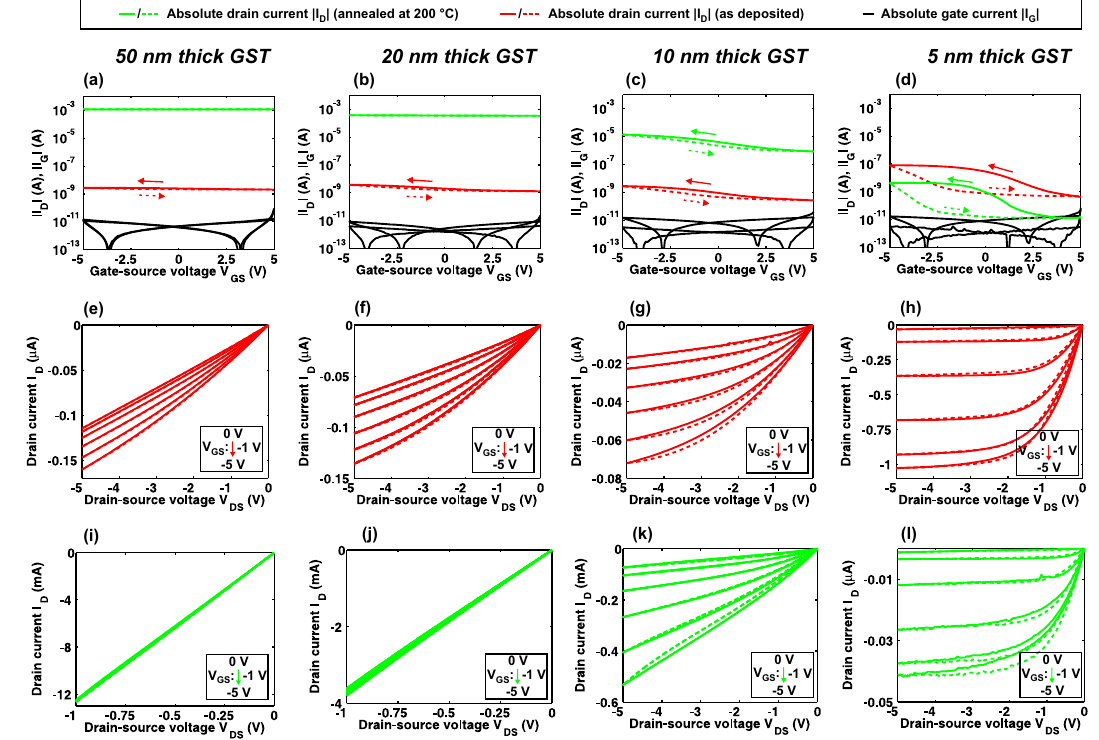
Figure 3. Electrical characteristics of GST thin-film transistors (TFTs) with channel lengths of 10 µ m and a channel widths of 100 µ m. Transfer characteristics at a drain-source voltage V DS = − 100 mV for ( a ) 50 nm, ( b ) 20 nm, ( c ) 10 nm and ( d ) 5-nm-thick GST. Output characteristics of amorphous (as deposited) GST TFTs for ( e ) 50 nm, ( f ) 20 nm, ( g ) 10 nm and ( h ) 5-nm-thick GST. Output